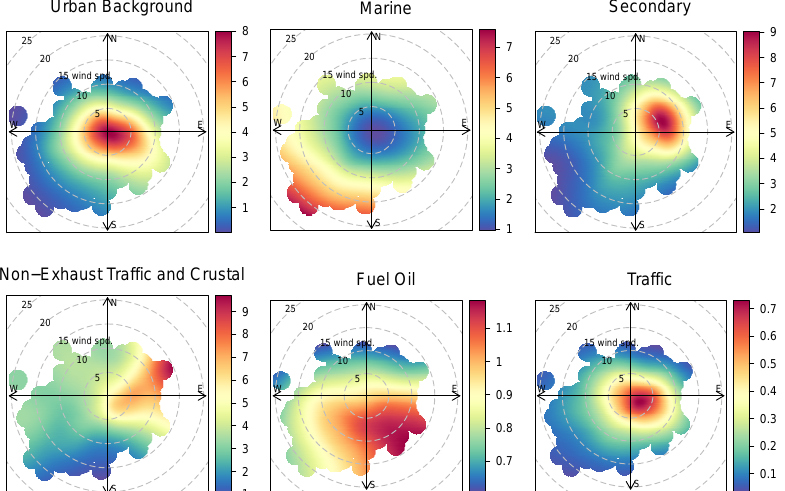
Figure 4. Polar plots showing how the daily PM 10 contributions are affected by the daily vector average wind direction and velocity (units: PM 10 (µgm − 3 ) and wind speed (ms − 1 )